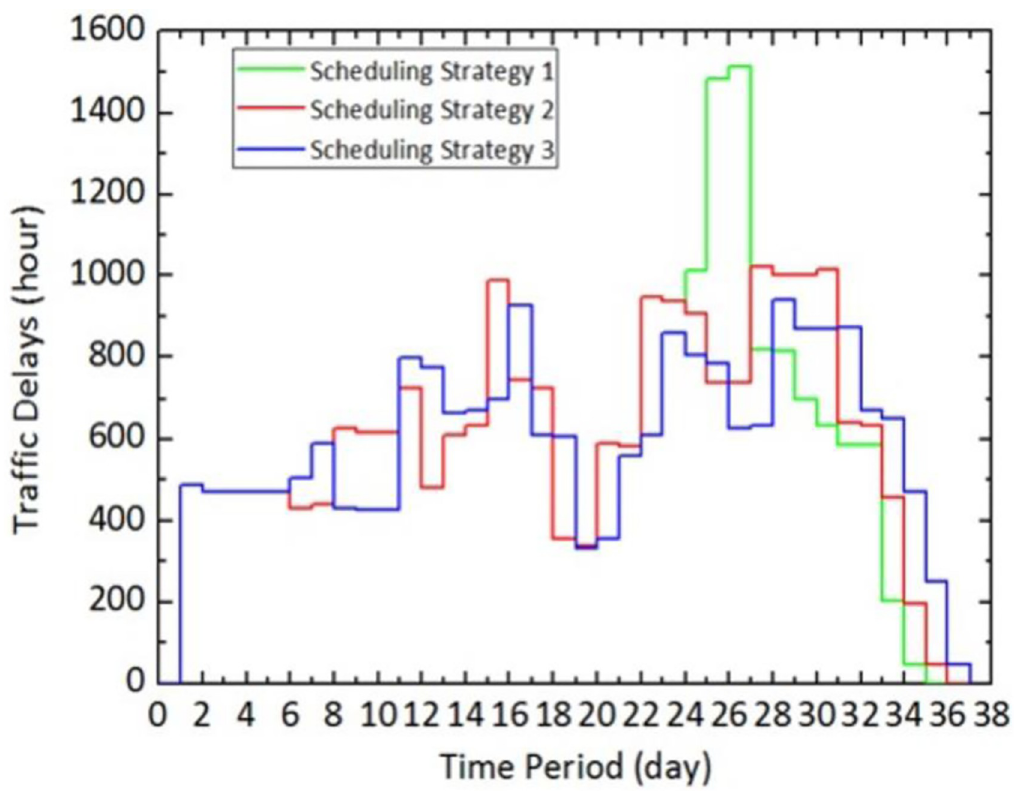
Fig 7. Day-to-day evolution of Z of the three different scheduling schemes ( θ = 0).